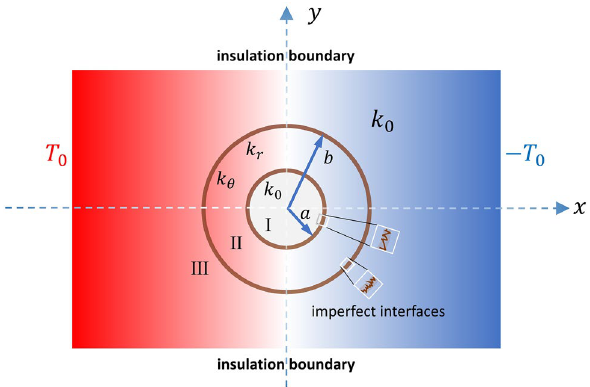
Figure 1. A schematic illustration of a circular thermal device with imperfect interfaces. Region I has an isotropic conductivity k = k 0 and is the targeted region for heat flux control. Region II is the designed region with constant radial and circumferential conductivities. Region III is the surrounding background material with the same isotropic conductivity as in Region I. The interfaces at r = a and r = b are imperfectly bonded with different interface